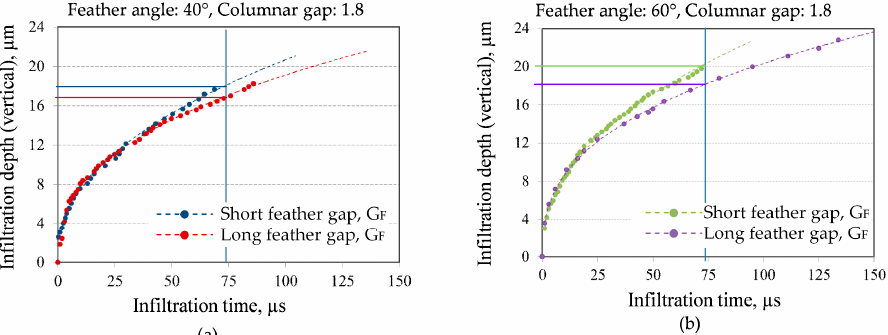
Figure 12. Vertical infiltration in columnar gaps with respect to geometrical factors variations, e.g., feather angle, feather arm length: ( a ) comparison for 40° inclined feathers with short and long arm; and ( b ) comparison for 60° inclined feathers with short and long arm.